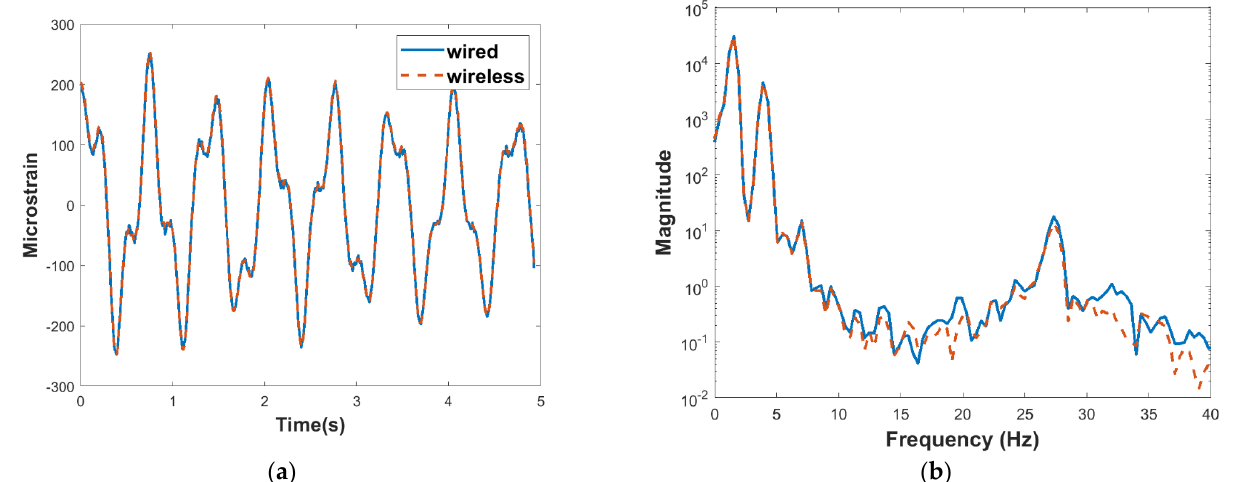
Figure 8. Dynamic strain verification. ( a ) Time domain comparison of strain response of wireless and wired sensing systems. ( b ) Power spectral densities of wireless and wired strain responses.